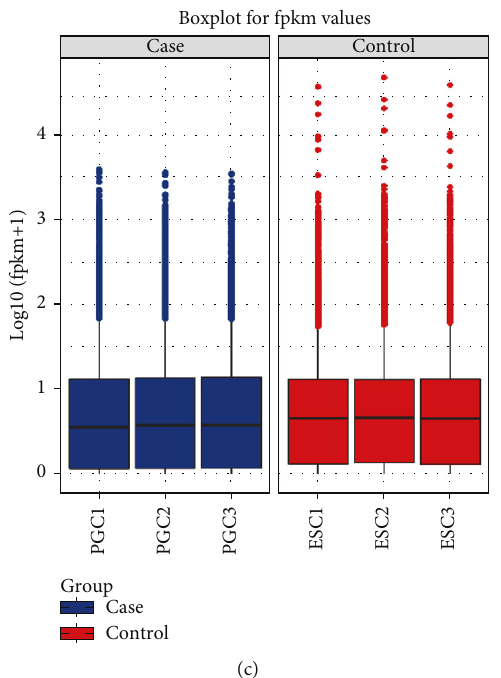
Figure 2: Analysis of cell transcriptome sequencing data. (a) Schematic diagram of RNA-seq analysis of ESCs and PGCs. DEGs: di ff erentially expressed genes; KEGG: Kyoto Encyclopedia of Genes and Genomes. (b) Heat map analysis of ESCs and PGCs. (c) Box plots of ESCs and